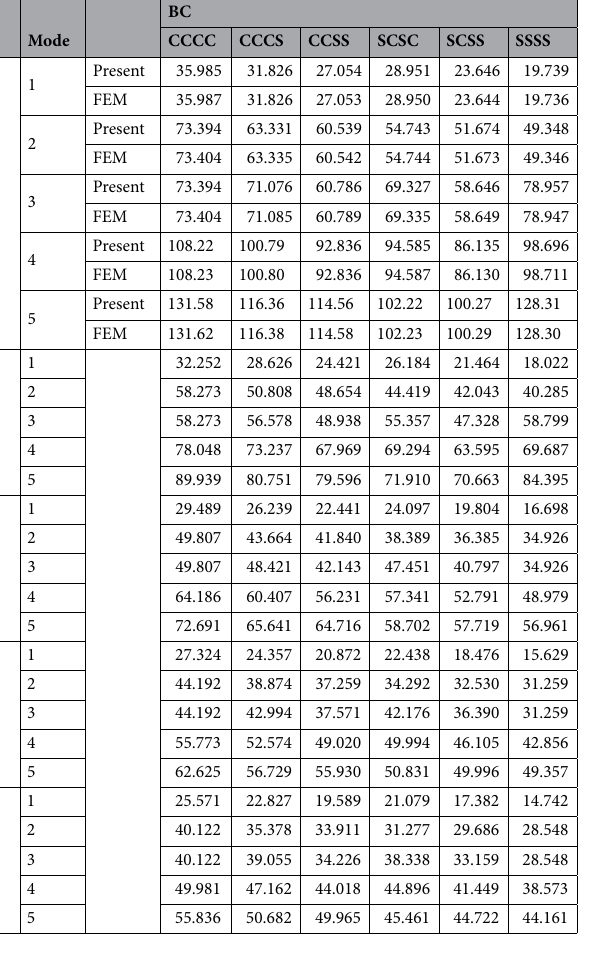
2 ρ h D , of square nanoplates with b = 10 nm under different (cid:31) (cid:30)